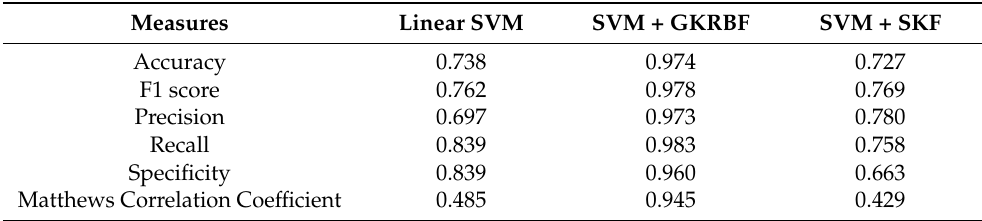
Table 3. Effectivity of models learned by linear SVM, SVM with GKRBF and SVM with SKF for recognition of troll users in online discussions.